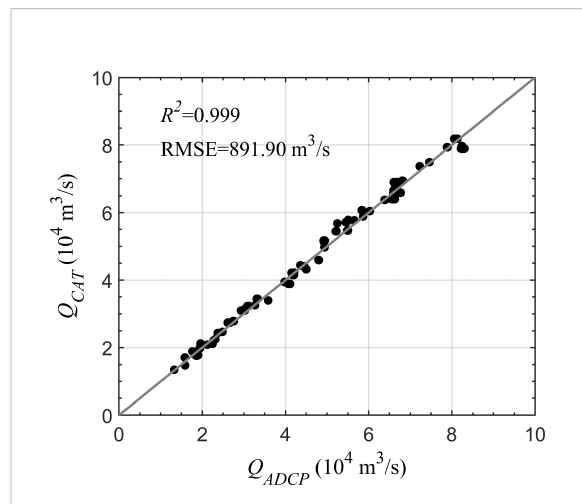
FIGURE 6 Comparison of discharge obtained by CAT and moving-boat